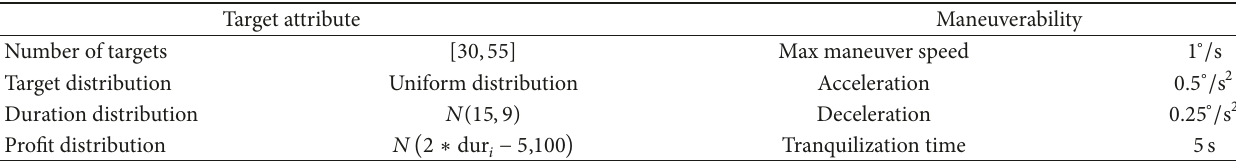
Table 1: Parameters of the instances and